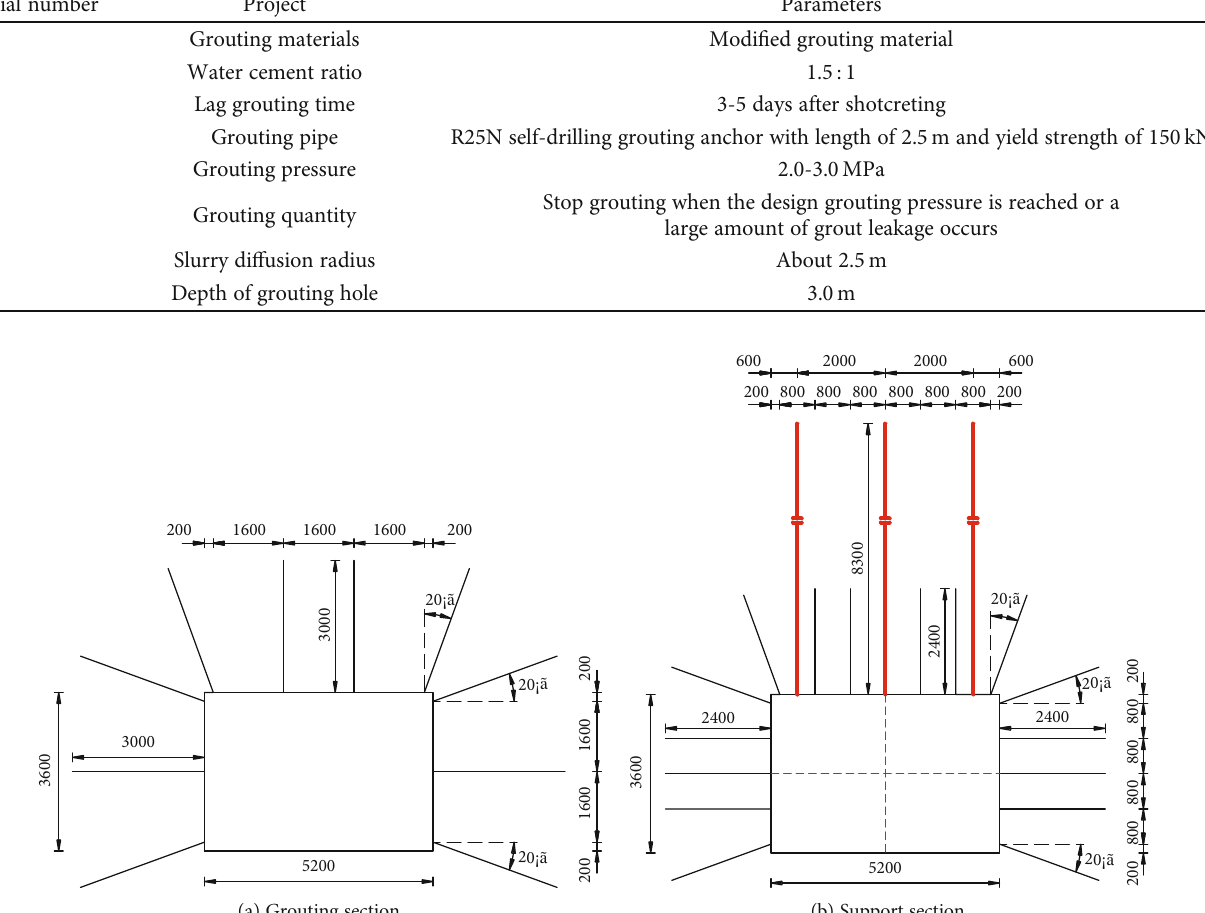
Table 9: The grouting parameters.